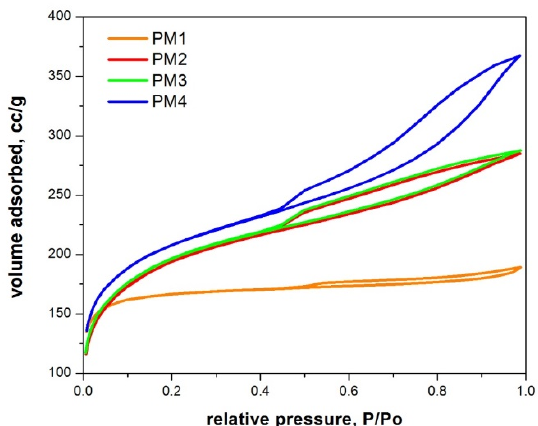
Figure 4. N 2 adsorption–desorption isotherms of magnetic nanocomposites.